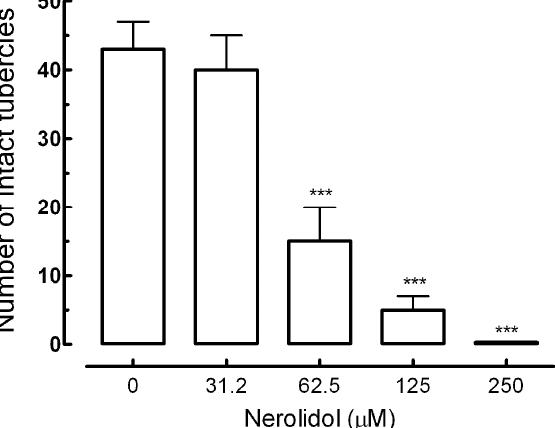
Figure 4. Morphological changes on the tegument of S. mansoni male worms after treatment with nerolidol. Quantitative analysis, measured in a 20,000 µm 2 of area in a dorsal region of male parasite, was performed using three-dimensional images obtained from confocal microscope (see Figure 3). A minimum of three tegument areas of each parasite were assessed. Values are means ± SD (bars) of ten male adult worms. *** p < 0.001 compared with untreated